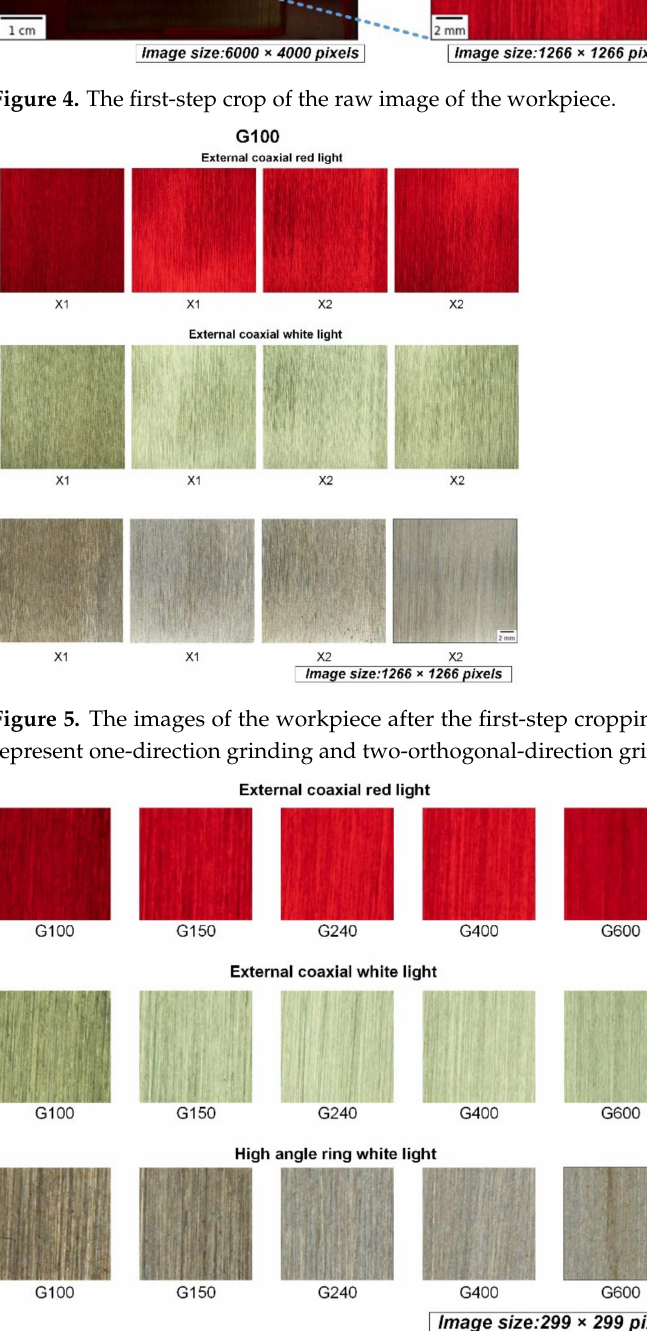
Figure 6. The images of the workpieces after second-step